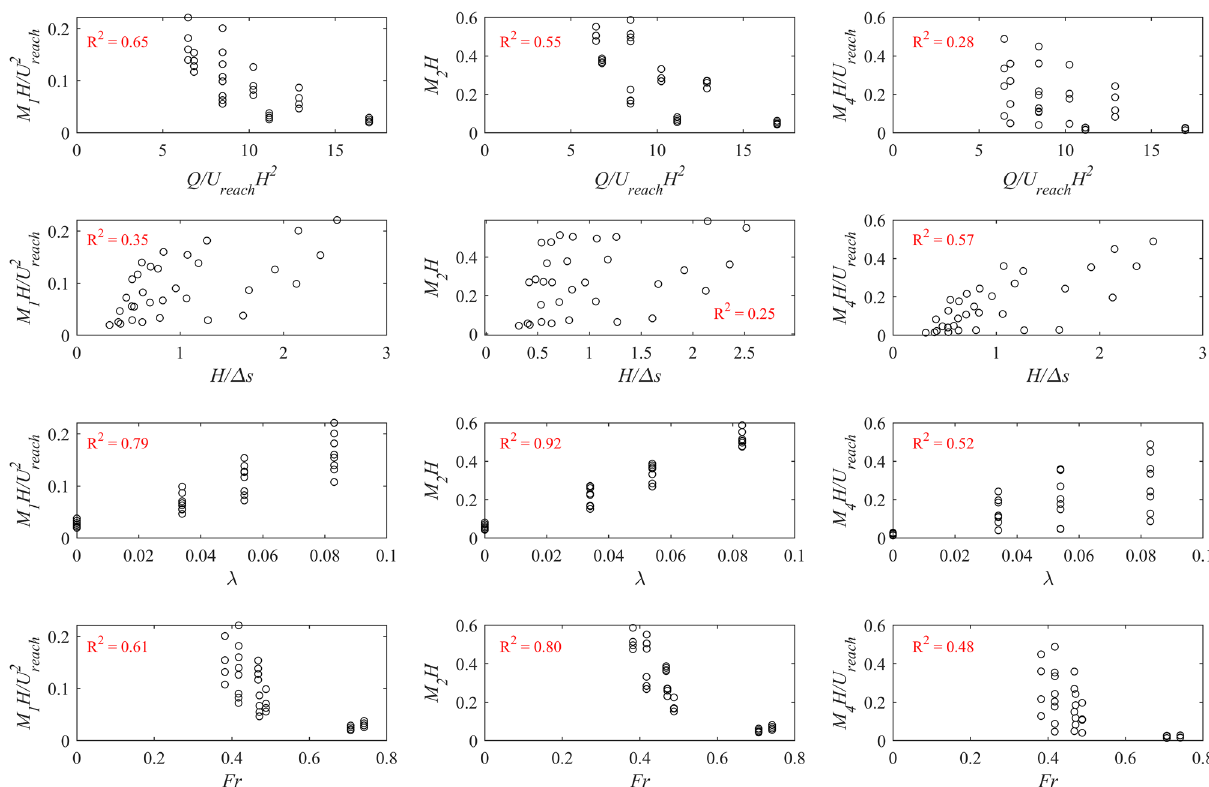
Figure 7. The relationships between the habitat hydraulic complexity metrics and derived dimensionless parameters from the dimensional analysis. M 1 is the kinetic energy gradient metric, M 2 is the normalized kinetic energy gradient metric, and M 4 is the modified recirculation metric. H is reach-averaged flow depth, U reach is reach-averaged flow velocity, Q is flow rate, Δs is grid spacing, λ is the boulder concentration, and Fr is Froude number. The shown R 2 values on each plot indicate the coefficient of determination from the best fit.